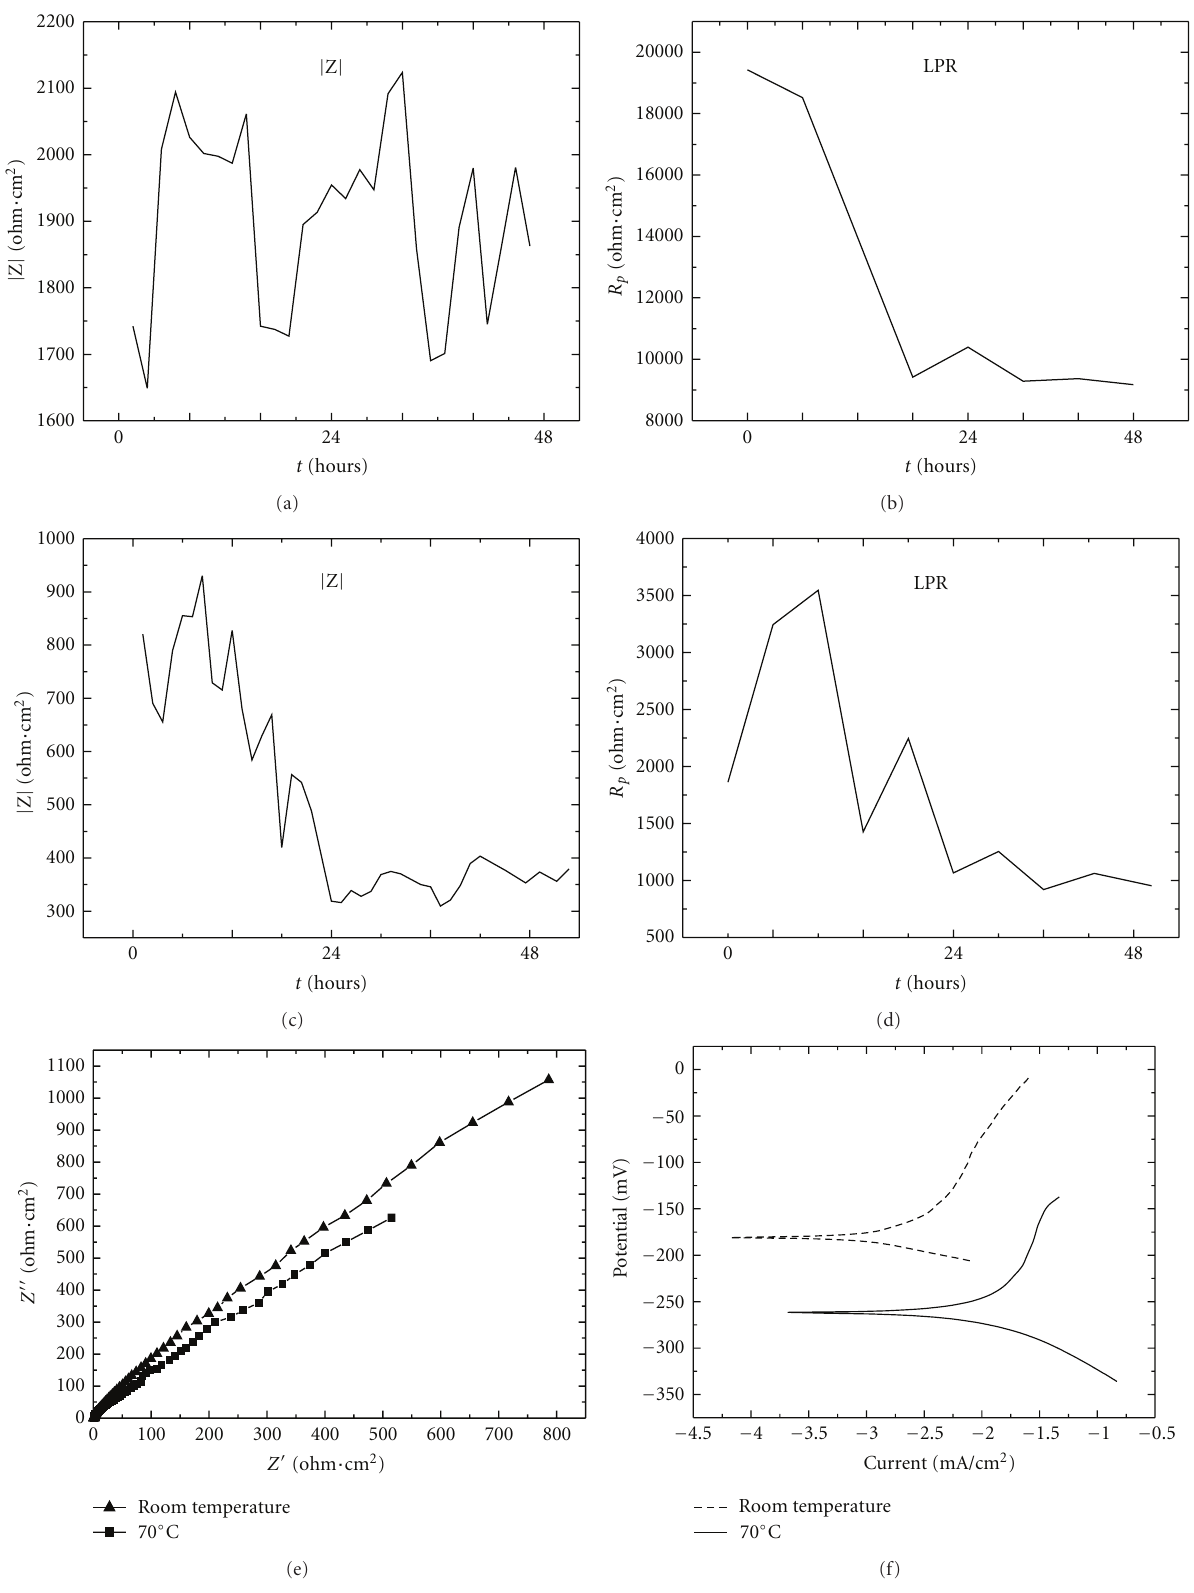
Figure 4: Electrochemical tests plots in the pH 3 solution, (a) | Z | at room temperature for 48 hours, (b) R p at room temperature for 48 hours, (c) | Z | at 70 ◦ C for 48 hours, (d) R p at 70 ◦ C for 48 hours, (e) EIS Nyquist plot at room temperature and 70 ◦ C, and (f) polarization curves at room temperature and 70 ◦